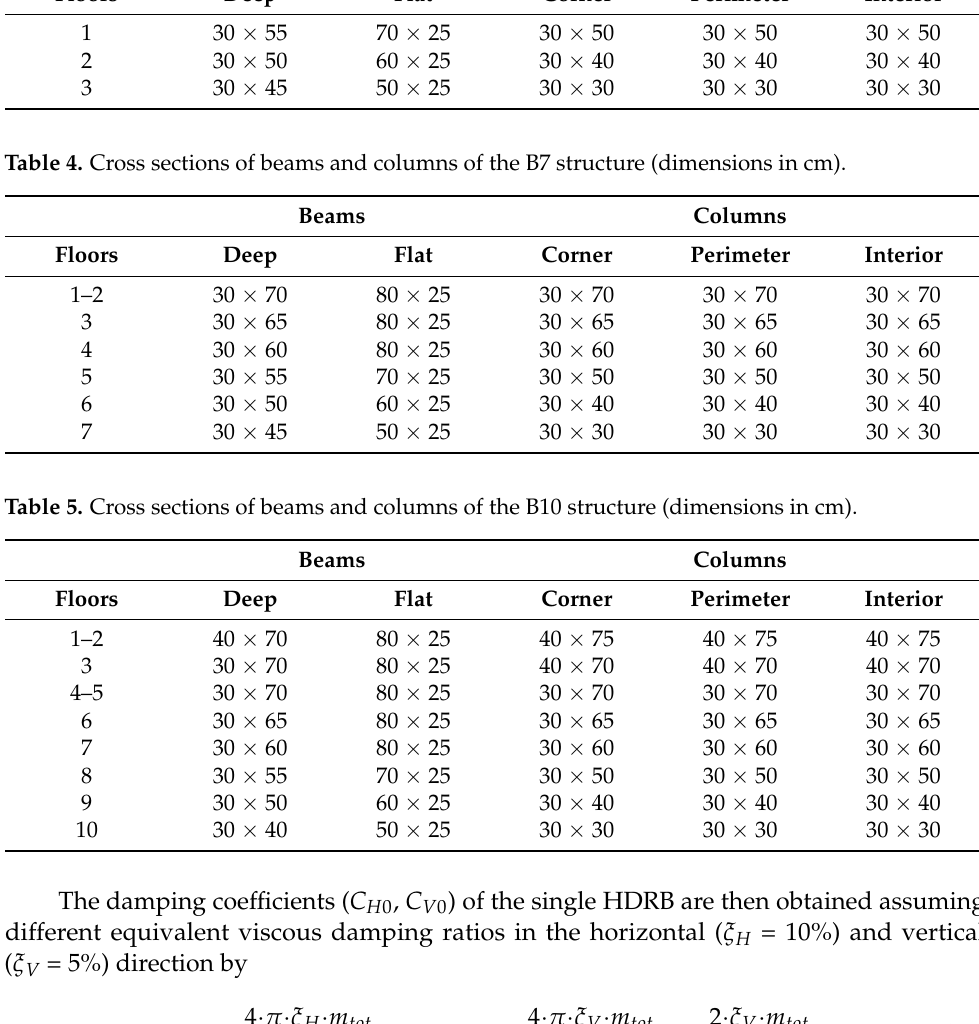
Table 3. Cross sections of beams and columns of the B3 structure (dimensions in cm). Beams Columns